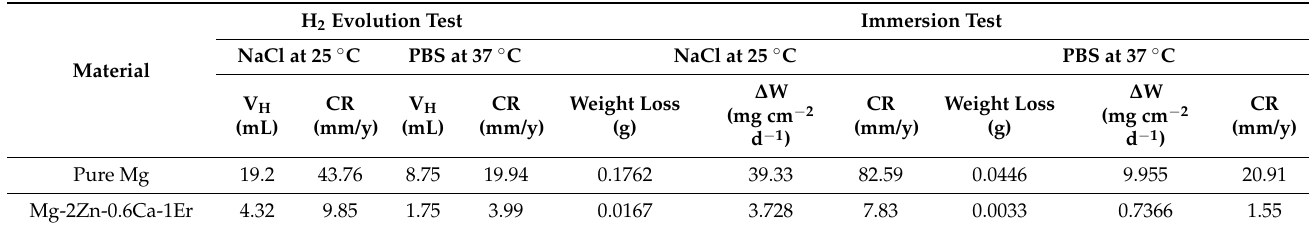
Table 4. Results of hydrogen evolution test and immersion tests performed on pure Mg and the quaternary alloy in NaCl at 25 ◦ C and PBS at 37 ◦ C